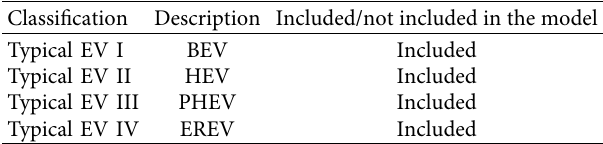
Table 1: Classifcation of electric